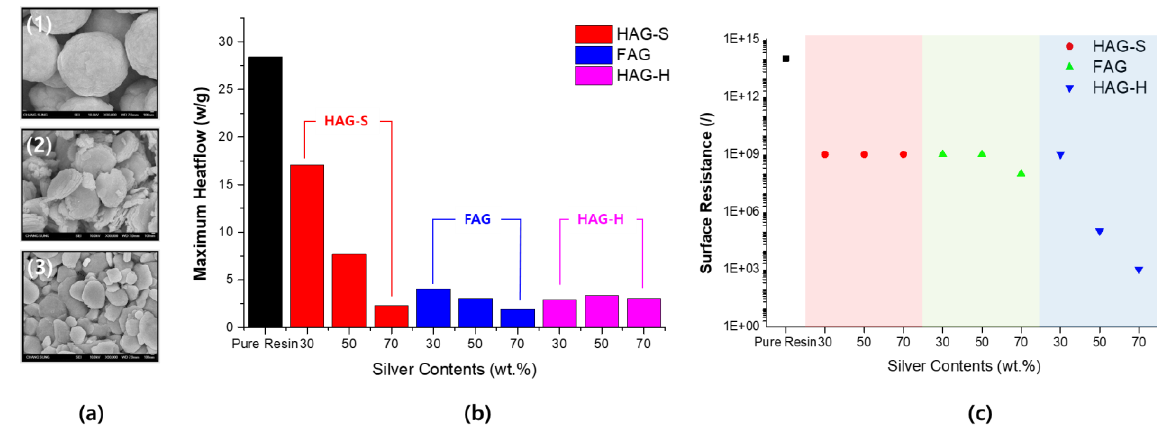
Figure 6. Curing properties and change in the surface resistance properties according to the type of metal particles. ( a ) SEM image of each silver particle applied to the conductive system 1:HAG-100S 2:HAG-100H 3:FAG-100S. ( b ) Reactivity in the UV curing process (peak of heat flow). ( c ) Comparison of surface resistance after UV curing.